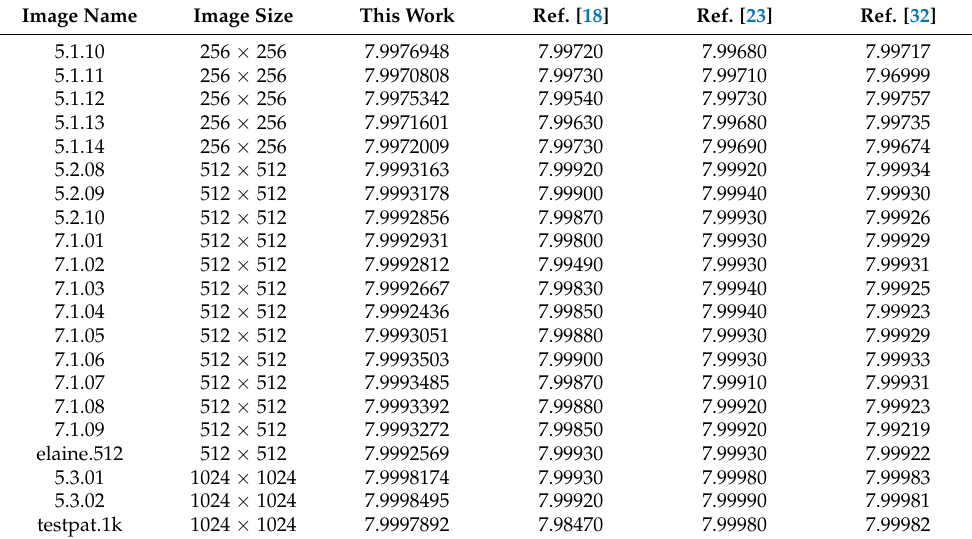
Table 7. Information entropy of encrypted images for several different